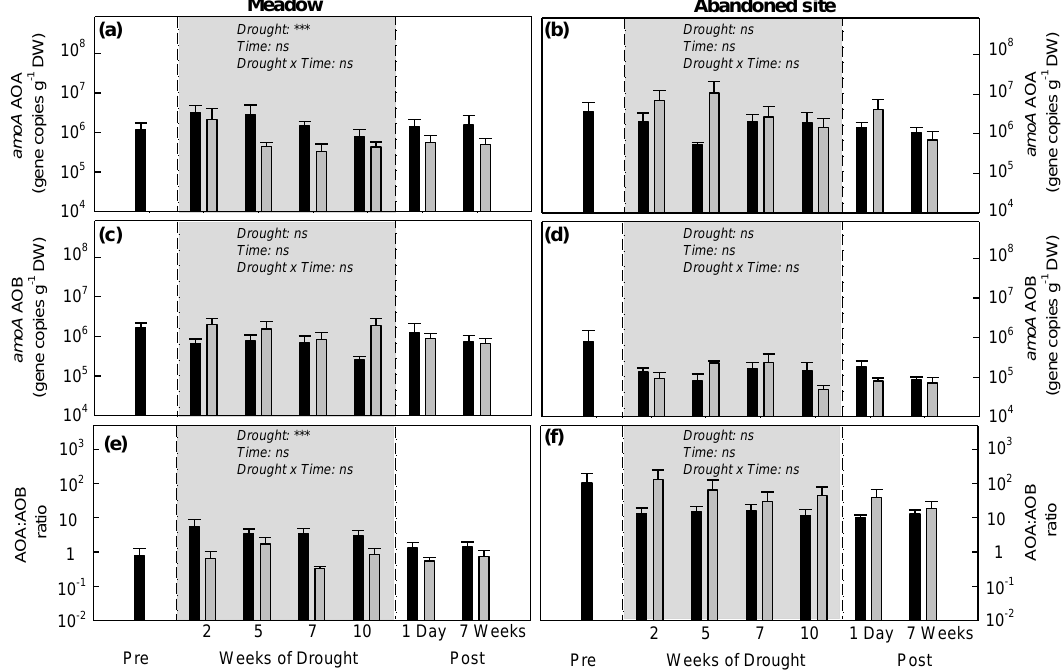
Figure 5 2 Figure 5. Gene copy numbers of ammonia-oxidizers at the meadow (left panel) and abandoned site (right panel) over the course of the experiment: (a, b) display archaeal ( amoA AOA) and (c, d) bacterial ( amoA AOB) amoA gene copy numbers, and (e, f) the ratio of AOA:AOB gene copy numbers. Black bars show controls, grey bars drought treatments ( n = 4, error bars indicate standard error). The grey background indicates the period of drought treatment. Differences between control and drought-treated plots at single sampling points assessed by t - tests with Bonferroni-corrected levels of significance. Effects of drought and sampling time were assessed by two-way repeated-measures ANOVA; for further details see Table